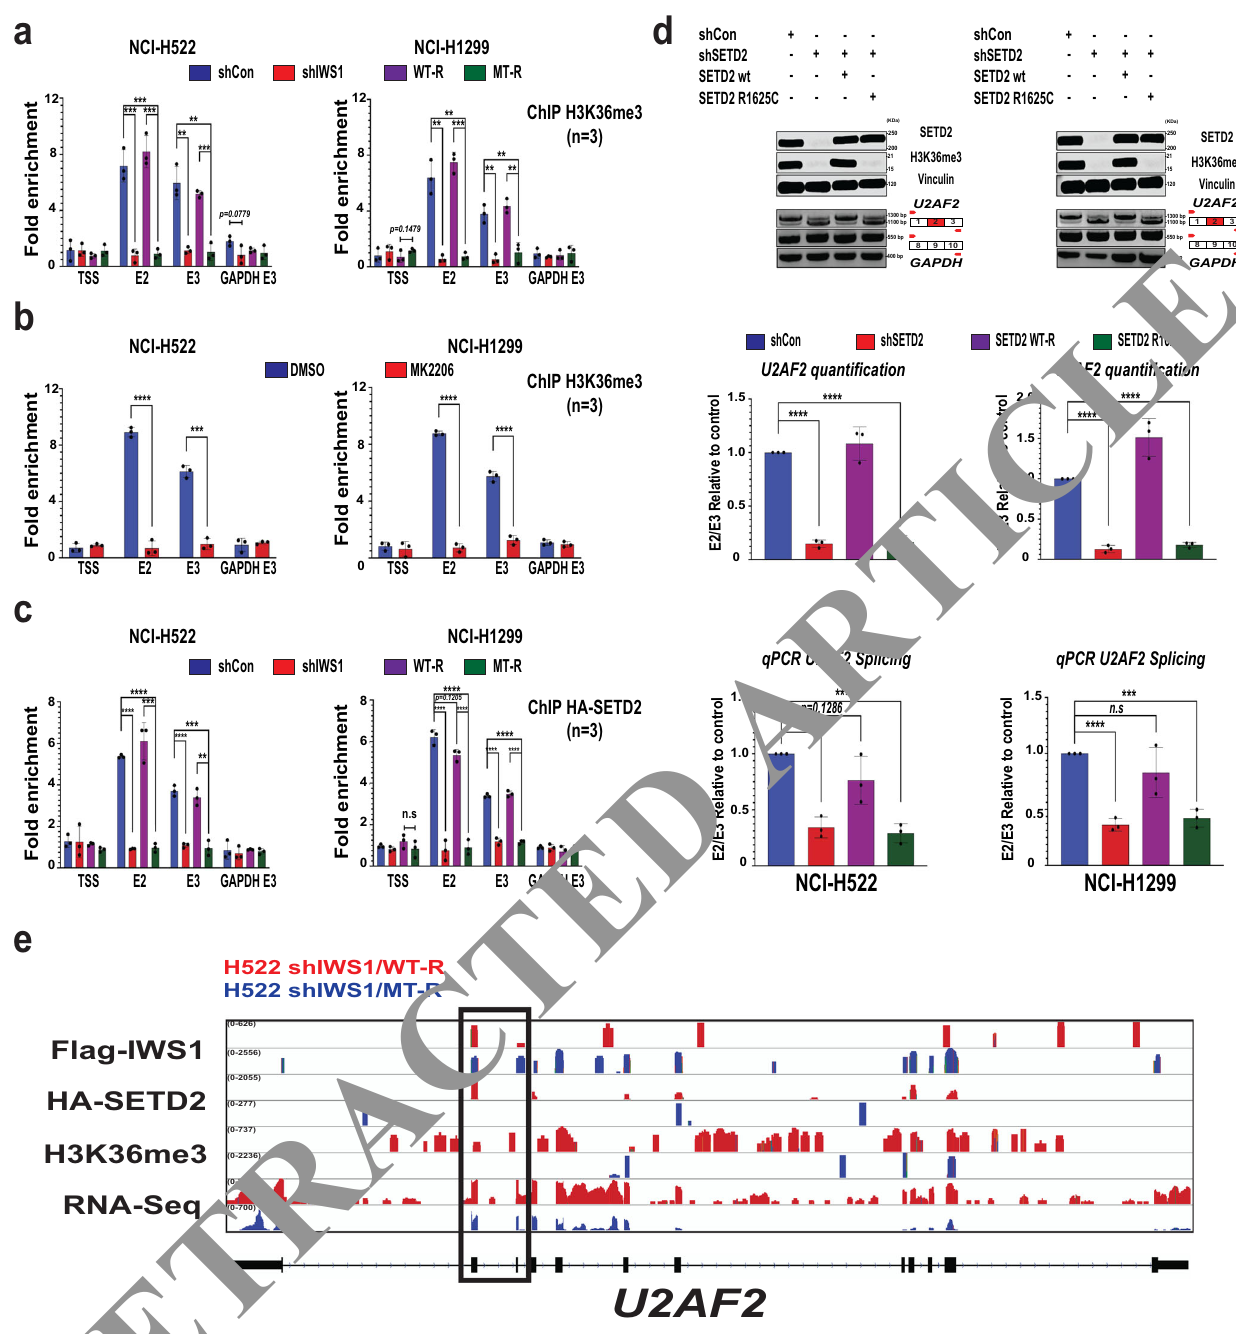
Fig. 3 U2AF2 Exon 2 inclusion, induced by IWS1 phosphorylation at Ser720/Thr721, depends on H3K36 trimethylation by SETD2. a ChIP assays showing the abundance of H3K36me3 in the indicated NCI-H522 (left) and NCI-H1299 (right) cells. Bars show the mean fold enrichment in H3K36me3 (anti-H3K36me3 IP, vs IgG control IP) in the indicated regions of the U2AF2 gene, in shControl, shIWS1, shIWS1/WT-R and shIWS1/MT-R cells ±SD. Data were normalized relative to the input (2%). b ChIP assays showing the abundance of H3K36me3 in the indicated NCI-H522 (left) and NCI-H1299 (right) cells, treated with MK2206 (5 μ M) or DMSO. The bars show the mean fold enrichment of H3K36me3 (anti-H3K36me3 IP, vs IgG control IP) in the indicated regions of the U2AF2 gene, ±SD. Data were normalized relative to the input (2%). c ChIP assays showing the binding of HA-SETD2 in the indicated NCI-H522 (left) and NCI-H1299 (right) cells, transduced with a lentiviral HA-SETD2 construct. The bars show the mean fold enrichment in SETD2 binding (anti-HA IP, vs IgG control IP) ±SD. Data were normalized relative to the input (2%). The expression of HA-SETD2 is shown in Supplementary fi gure 4a. d (Upper panel) Lysates of NCI-H522 (left) and NCI-H1299 (right) cells transduced with the indicated constructs, were probed with the antibodies, as shown. RT-PCR addressing U2AF2 exon 2 splicing in the same cells. (Middle panel) GAPDH -normalized E2 and E3 bands in the RT-PCR experiment above, were used to calculate the E2/E3 ratio±SD. (Lower panel) Ratio of the U2AF2 exons 2 and 3 levels in the same cells ±SD, as determined by quantitative RT-PCR. E2/E3 ratio is shown relative to shControl (value = 1). All experiments had three biological replicates, all done in triplicate. n.s non-signi fi cant, * p < 0.05, ** p < 0.01, *** p < 0.001, **** p < 0.0001 (one-sided unpaired t - test). e Snapshots of the integrative genomic viewer showing the ChIP-Seq-determined distribution of Flag-IWS1, HA-SETD2, and histone H3K36me3, in U2AF2 . Parallel snapshots show the distribution of RNA reads in the RNA-seq experiment. Scale represents reads per million (RPM). Snapshots of peaks detected in the two biological replicates are shown. Black box highlights U2AF2 exons 2, 3 and adjacent regions.